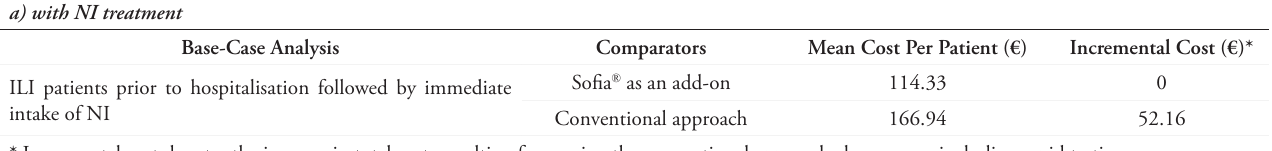
Table 2. Results of the base-case analysis (with and without NI treatment)